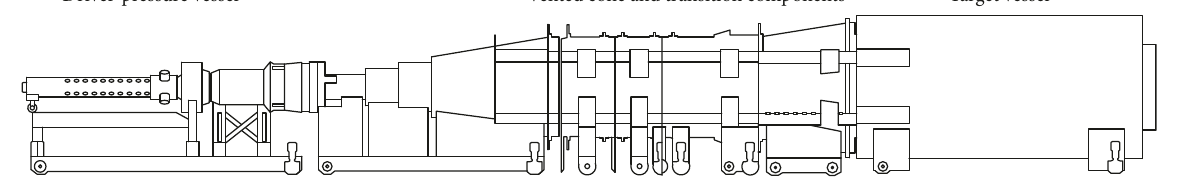
Figure 3: Schematic representation of Vicksburg BLS [10].